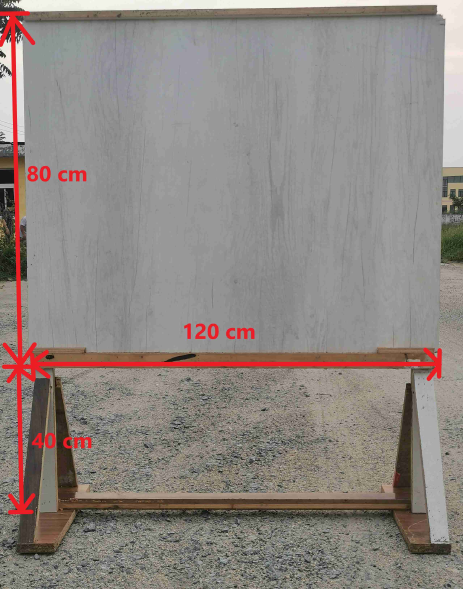
Figure 2. Specification of the frame and the blocker (metal in this figure).